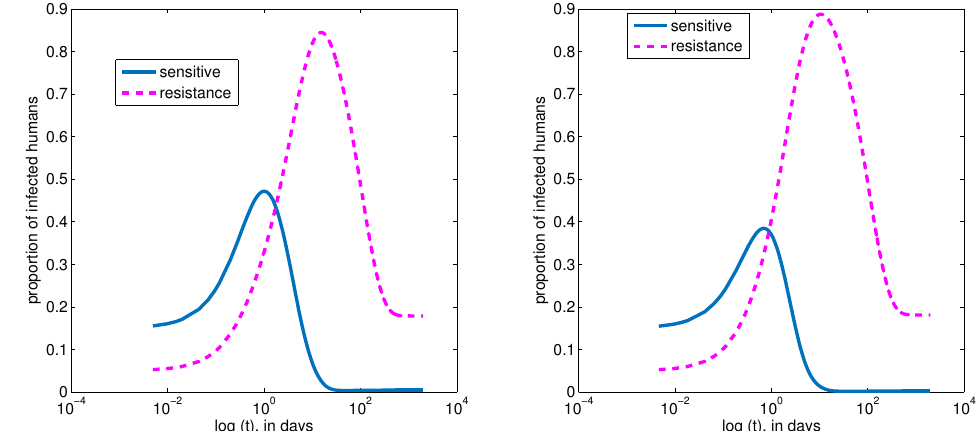
Figure 2. Numerical simulation of Model (15) showing the proportion of infected humans with both sensitive and resistant strains using the initial condition ( v , w , x , y , g , h ) = ( 0.15,0.05,0.01,0.001,0.2,0.6 ) . ( a ) With the baseline values in Table 3; ( b ) With the baseline values except T s changed to